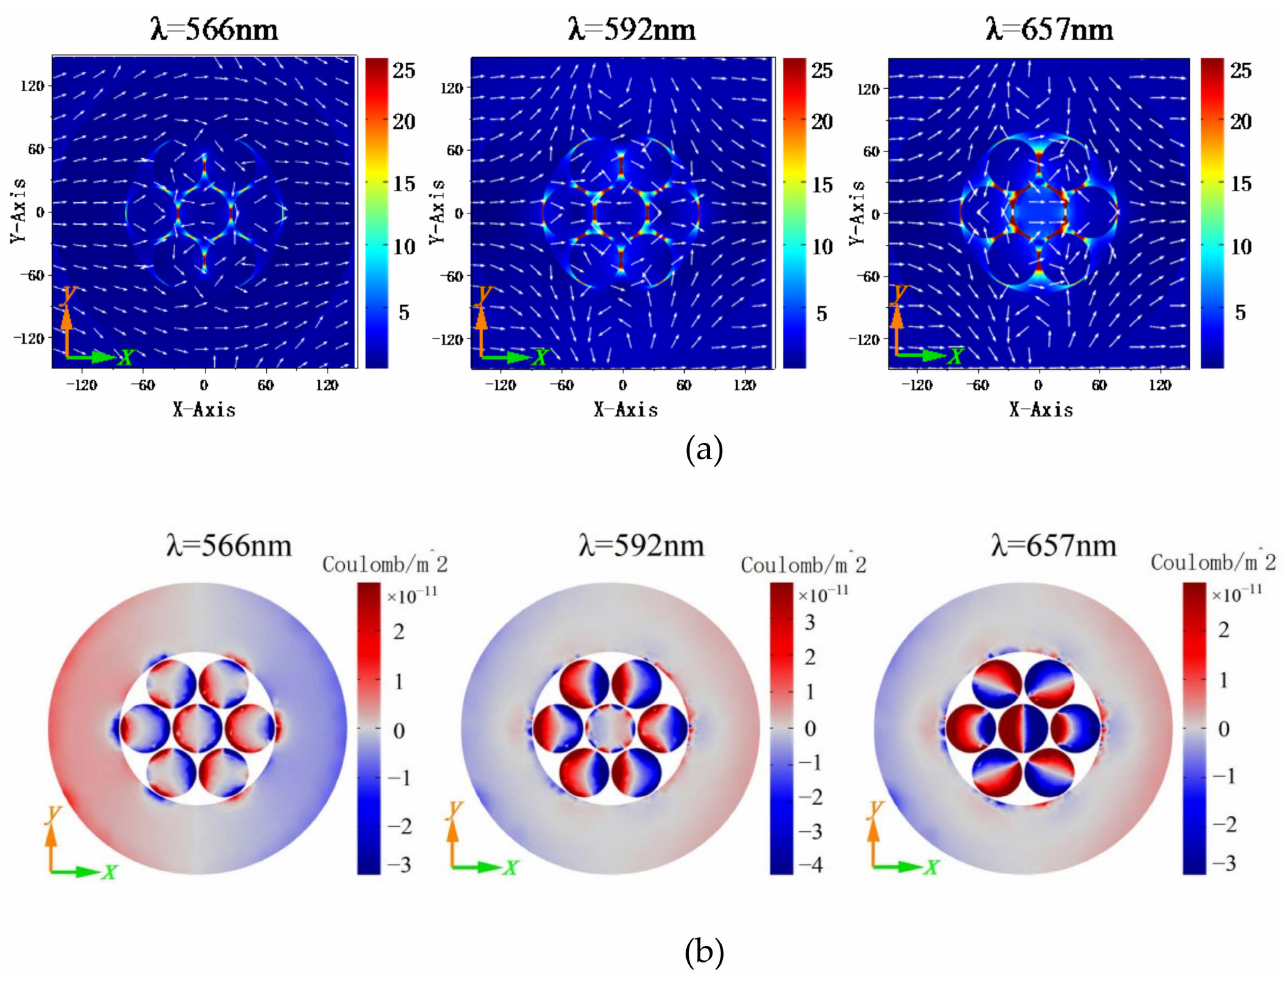
Figure 3. ( a ) Normalized electric field enhancement at the Fano dips and ( b ) charge distributions at the Fano